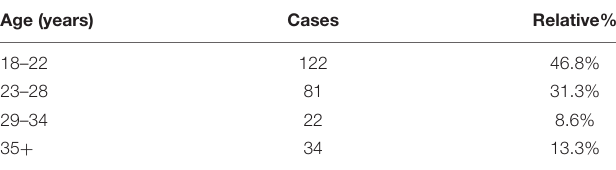
TABLE 2 | Distribution by age.